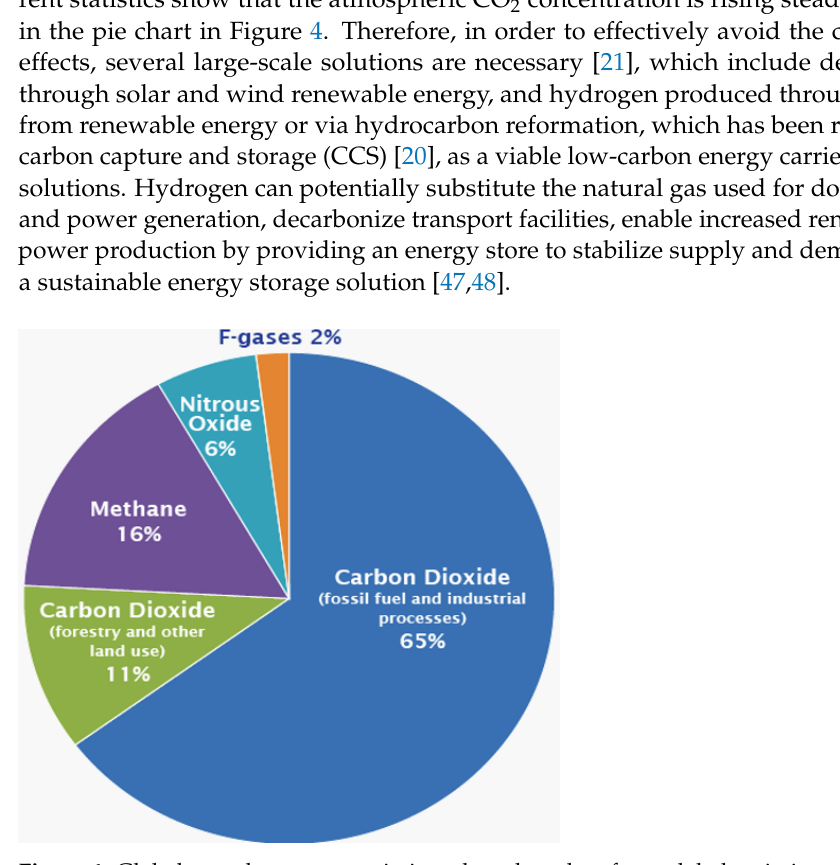
Figure 4. Global greenhouse gas emissions, based on data from global emissions from 2010 (Data from IPCC, 2014